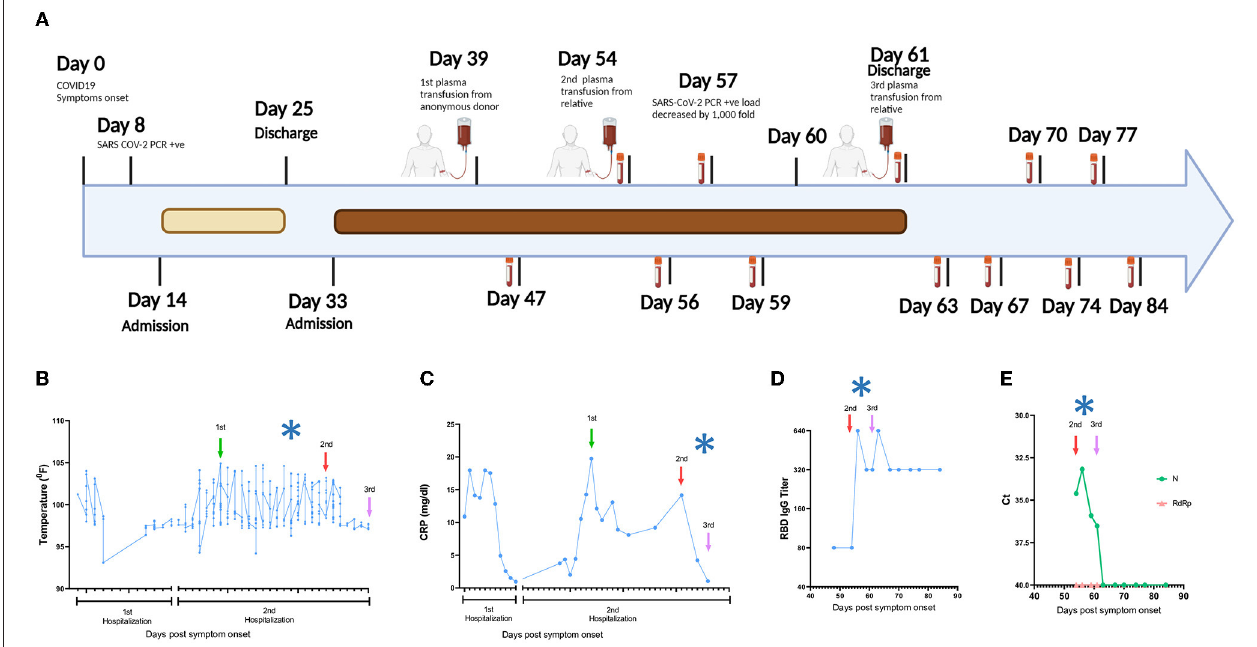
FIGURE 1 | Timeline of the clinical course. (A) Day 0 indicates the date of the COVID-19 symptom onset. The days post-onset at which COVID-19 related symptoms, hospitalization course, RT-PCR test results, convalescent plasma transfusions, and interventions are indicated. (B–E) Longitudinal analysis of (B) maximum body temperature, (C) C- Reactive protein (CRP) in plasma, (D) Titers of IgG against SARS-CoV-2 Spike Receptor binding domain (RBD), and (E) SARS-CoV-2 RNA in plasma. The y axis in each panel indicates the corresponding measurement unit. In all panels, the x axis indicates the day numbering as depicted in (A) . In (B,C) , the timeline in the x axis highlights the first hospitalization (days 14–25) and the second hospitalization (days 33–61), since the corresponding measurements were performed only in the hospital. In all panels, the vertical arrows indicate convalescent plasma transfusions from anonymous donor (1st) and from a patient’s relative (2nd and 3rd). The asterisk indicates the drop in viral load recorded at day 57 (A) . The low-level anti-RBD IgG seen pre-transfusion (D) are consistent with the lack of B cell detection in the patient’s peripheral blood by clinical flow cytometry tests (data not shown), which are presumably due to the use of rituximab and/or methotrexate for MAS, since treatment with these drugs can reduce B cell frequencies and humoral immune responses (13, 14). In (E) , Ct, cycle threshold; N, SARS-CoV-2 nucleocapsid gene; RdRP, SARS-CoV-2 RNA-dependent RNA polymerase